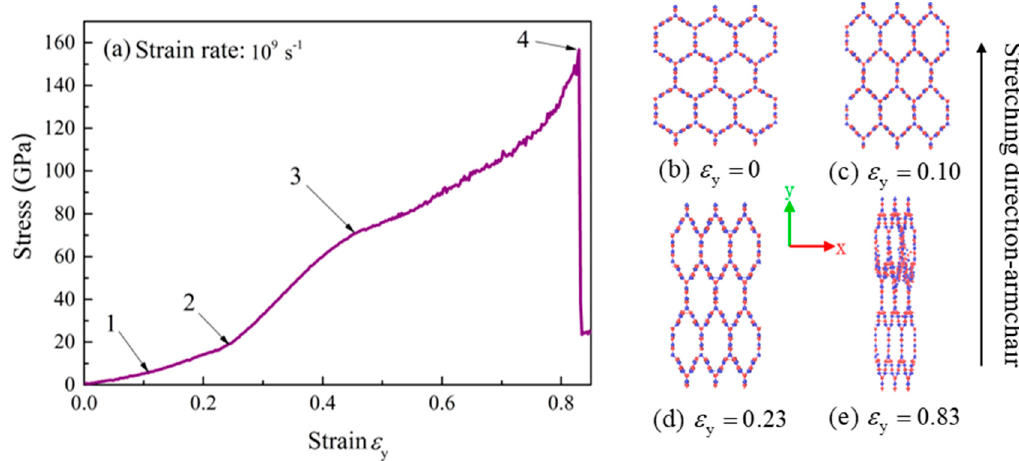
Figure 4. ( a ) The stress-strain curve of BNHCs under tensile loading along the armchair direction; ( b – e ) Deformation of BNHCs under different tensile strains along the armchair direction.